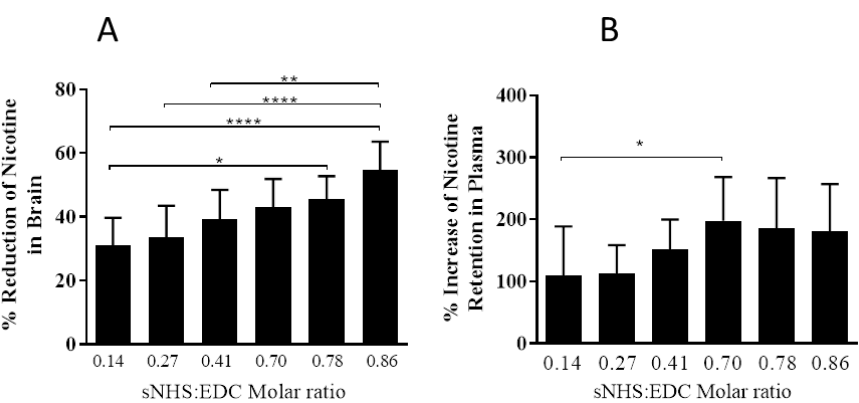
Figure 5. The effect of different sNHS/EDC ratios on Ab function. BALB/c mice ( n = 10/group) were immunized on Days 0 and 21 by IM injection with 10 µ g of NIC7-CRM conjugates adjuvanted with alum (10 µ g Al 3+ ) + CpG (20 µ g). On Day 28, animals received an IV injection of 3 H-nicotine (0.05 mg/kg) and plasma and brains collected. Panel ( A ) shows % reduction of nicotine levels in